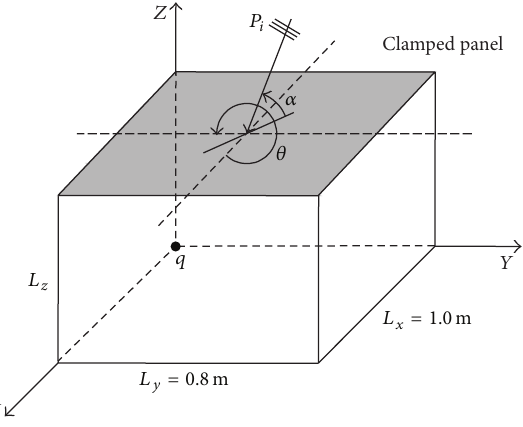
Figure 1: Panel-enclosure geometry and coordinate